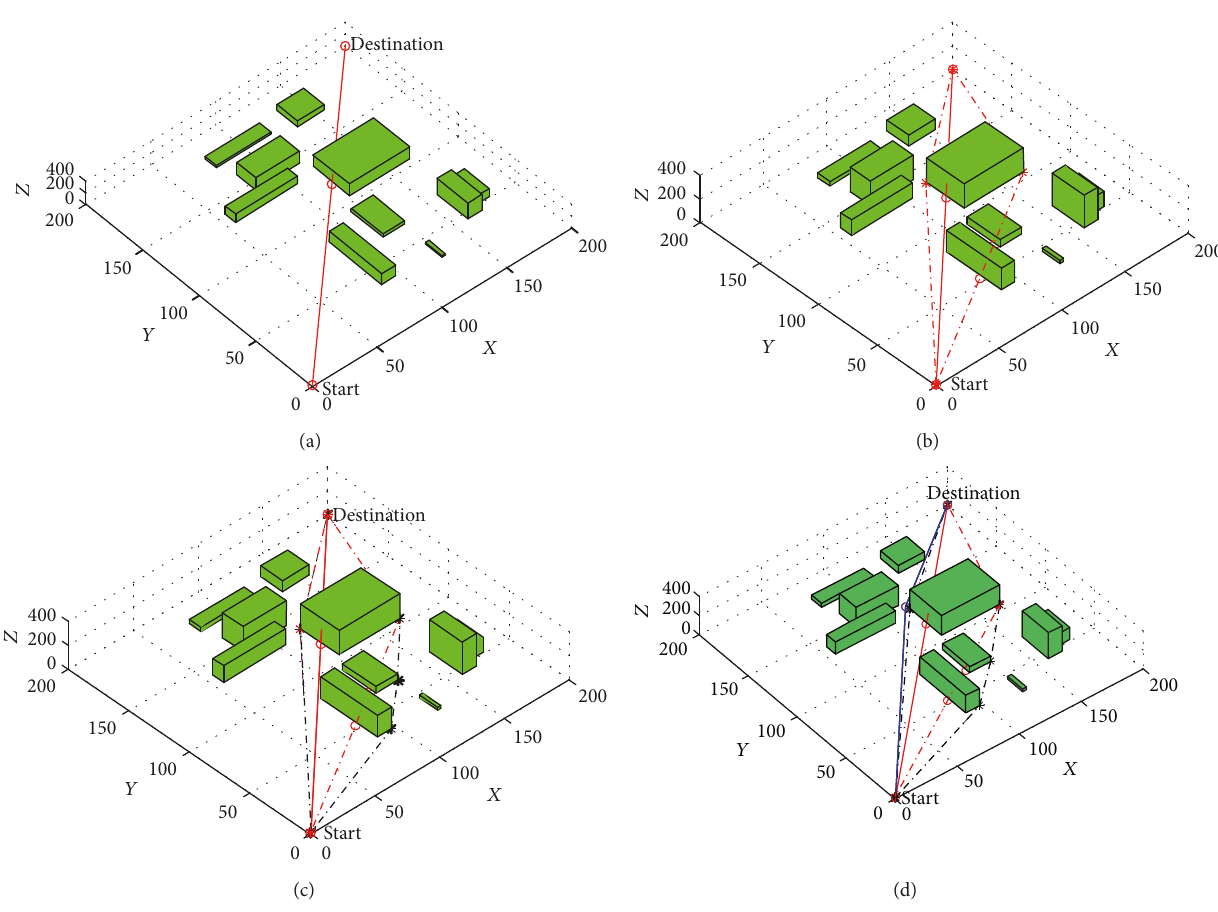
Figure 8: Explanation of bounded energy space selection algorithm. (a) Energy axis between source and destination. (b) Selection of energy space 1. (c) Selection of energy space 2. (d) Selection of path in the bounded energy